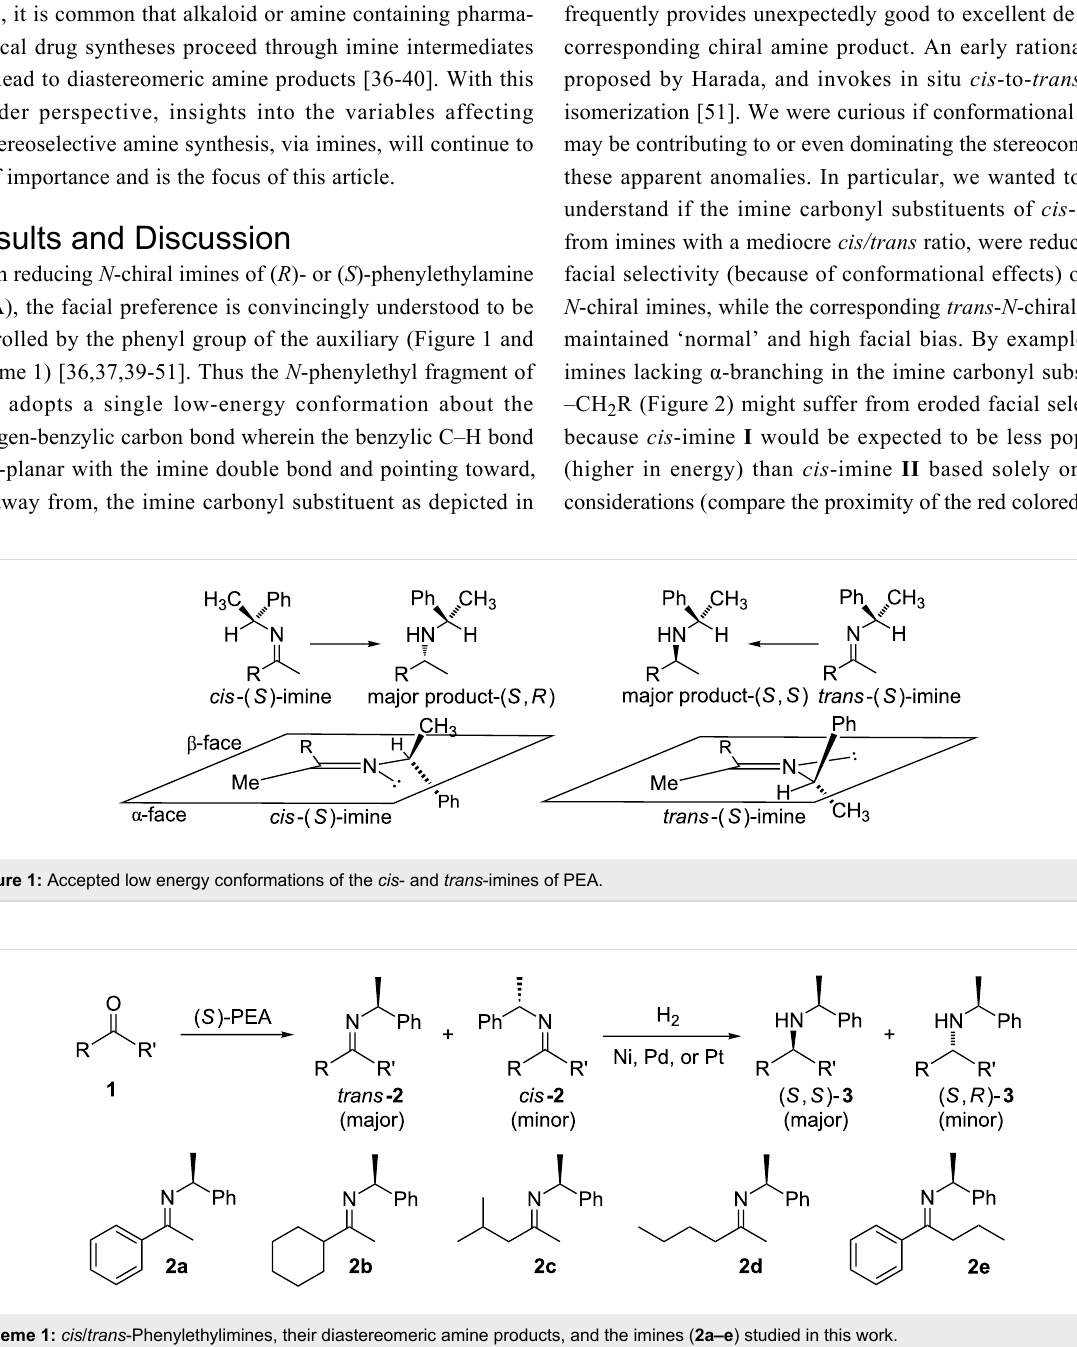
Scheme 1: cis / trans -Phenylethylimines, their diastereomeric amine products, and the imines ( 2a–e ) studied in this